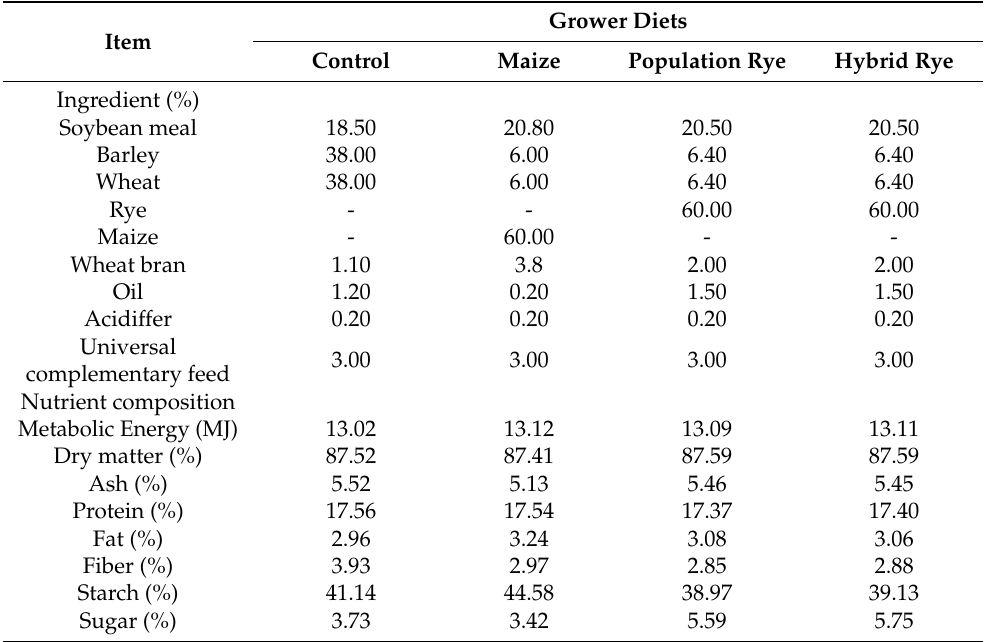
Table 1. Composition of the grower mixtures used in control and experimental groups of pigs during the first 40 days of fattening.